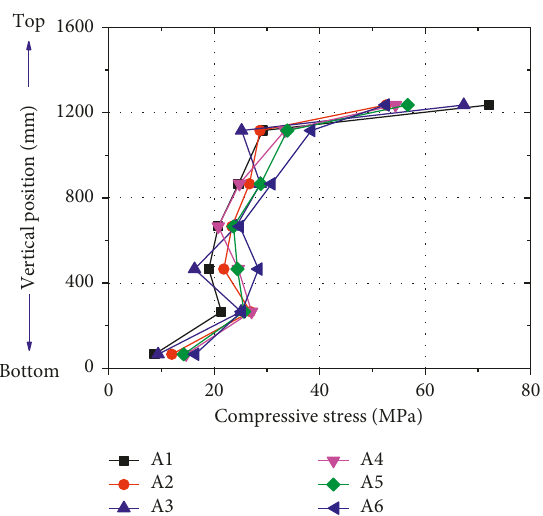
Figure 10: Stress distribution of the steel